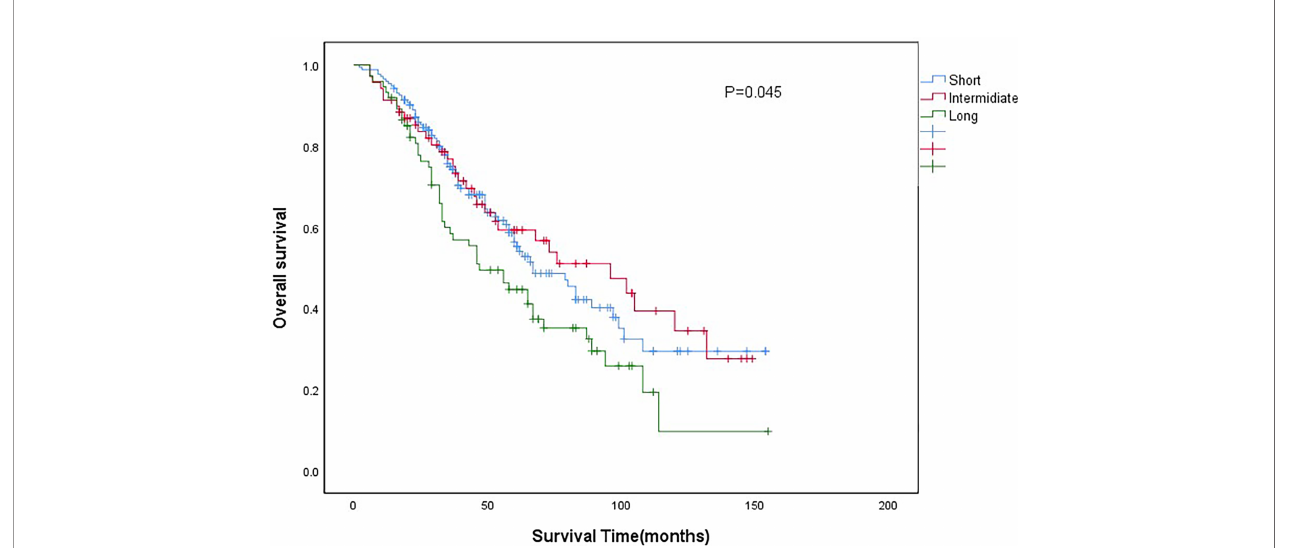
FIGURE 1 | Comparison of overall survival curves between patients with different wait